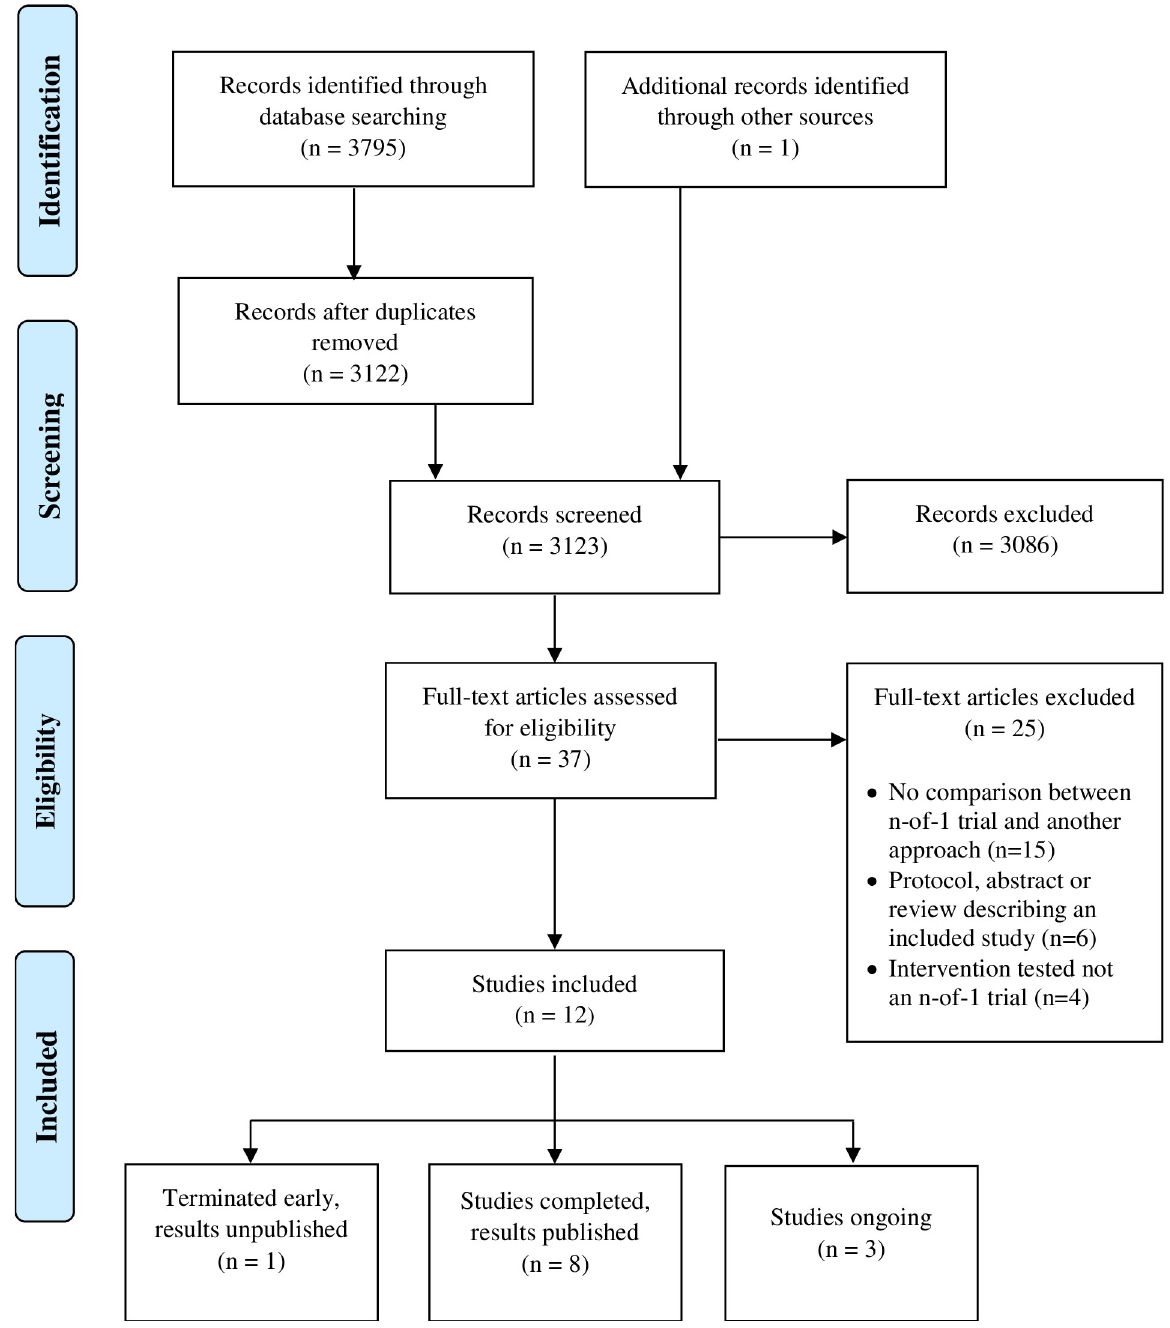
Fig 1. Preferred Reporting Item for Systematic Reviews and Meta-Analyses (PRISMA) flow